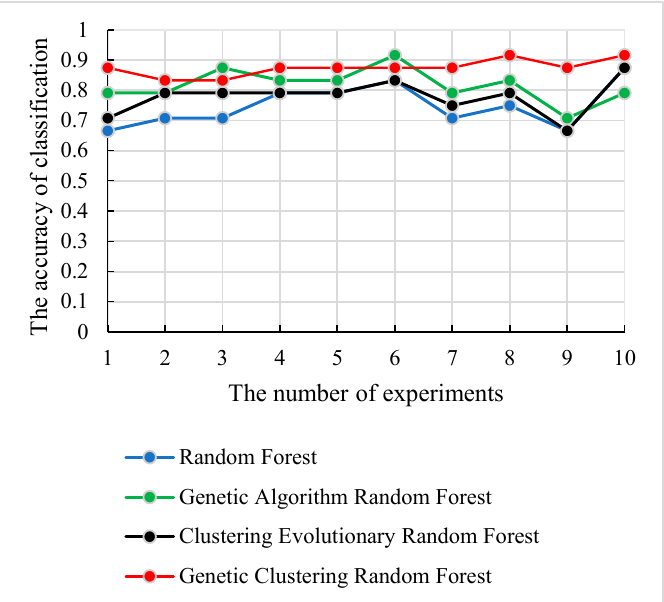
Figure 9. The relationship curves of accuracy and the four methods in 10 experiments.